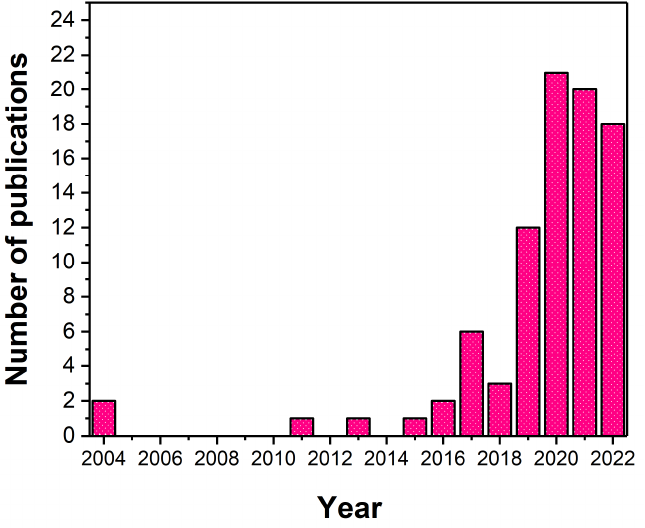
Figure 2. The number of publications of thermal spray high-entropy alloy coatings per year until December 2022 (exported with Scopus analysis tool).